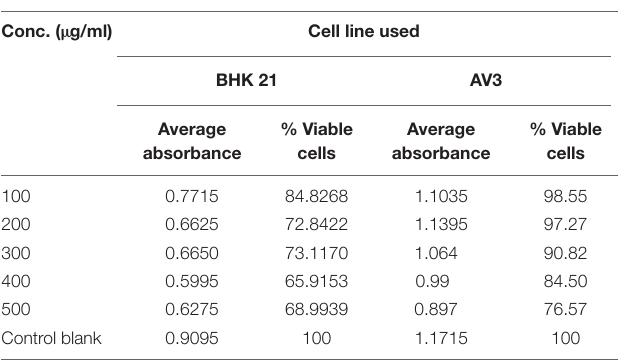
TABLE 9 | Toxicity testing with MTT assay.